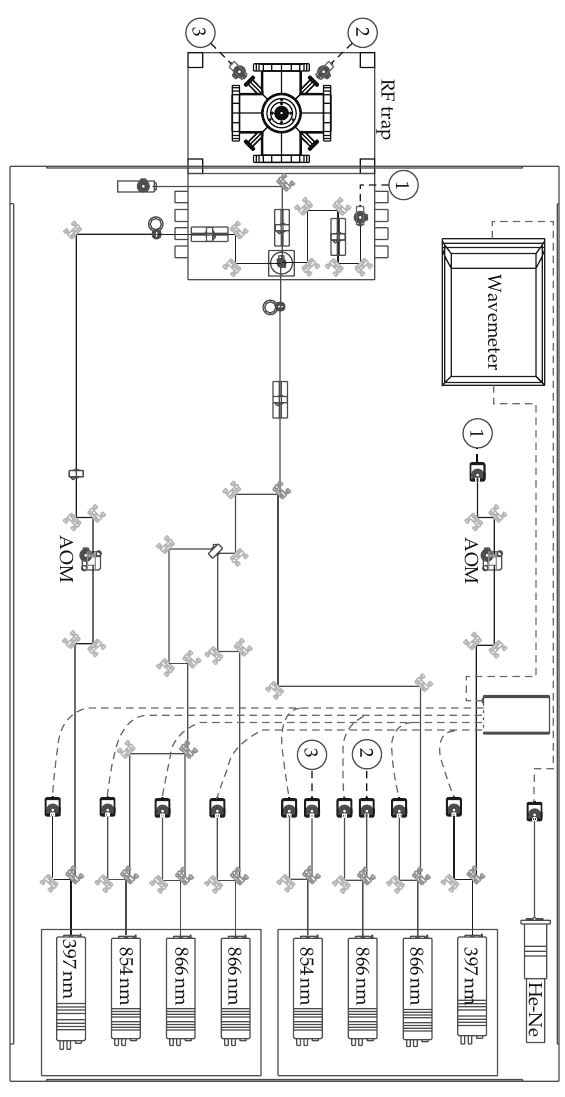
Figure 7: Optical table with the laser system and associated elements to perform laser cooling of 40 Ca (cid:8) . For details see